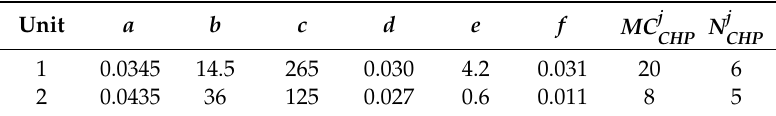
Table 2. Data of the CHP units.